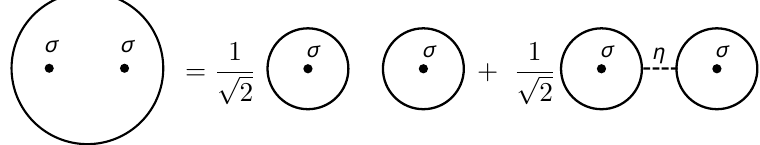
Figure 30 . Applying partial fusion to the two-point function of spin (cid:12)elds h (cid:27) ( x ) (cid:27) (0) i circled by an N